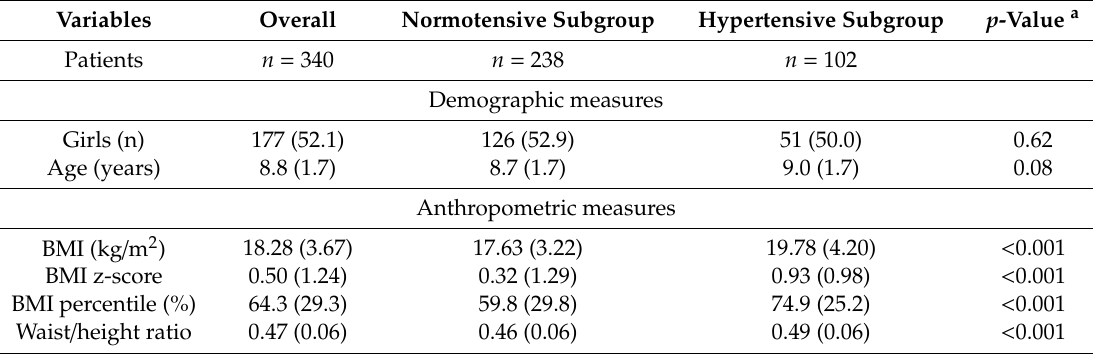
Table 1. Demographic, anthropometric, body composition and blood pressure measures of the overall cohort as well as normotensive and hypertensive